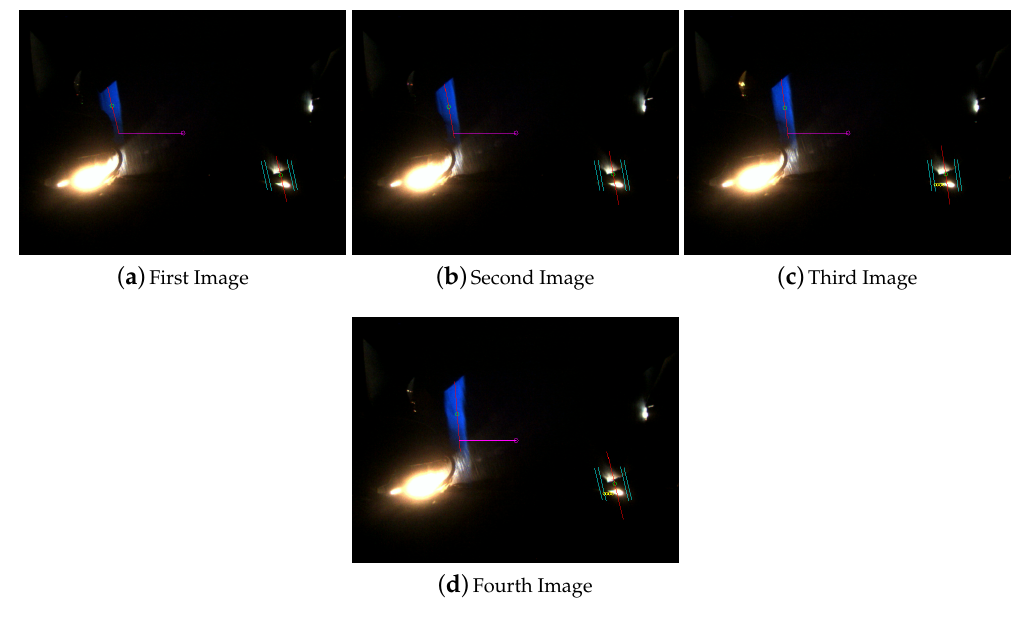
Figure 20. Visual mark wrong detection